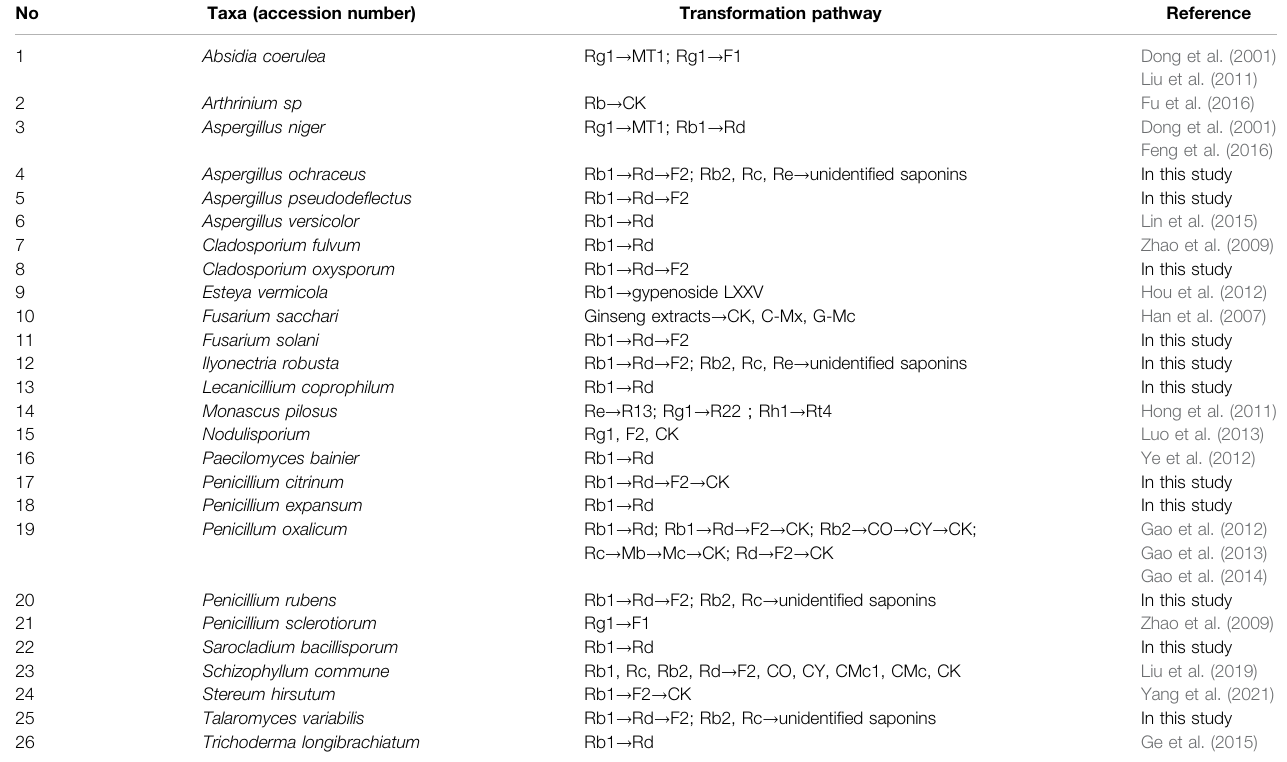
TABLE 4 | Summary of the transformation pathway for major ginsenosides by different fungi.